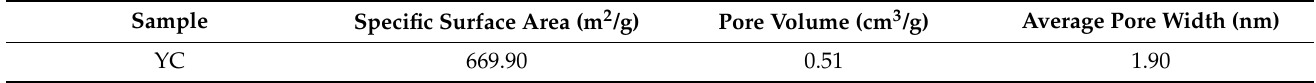
Table 1. Pore structure parameters of